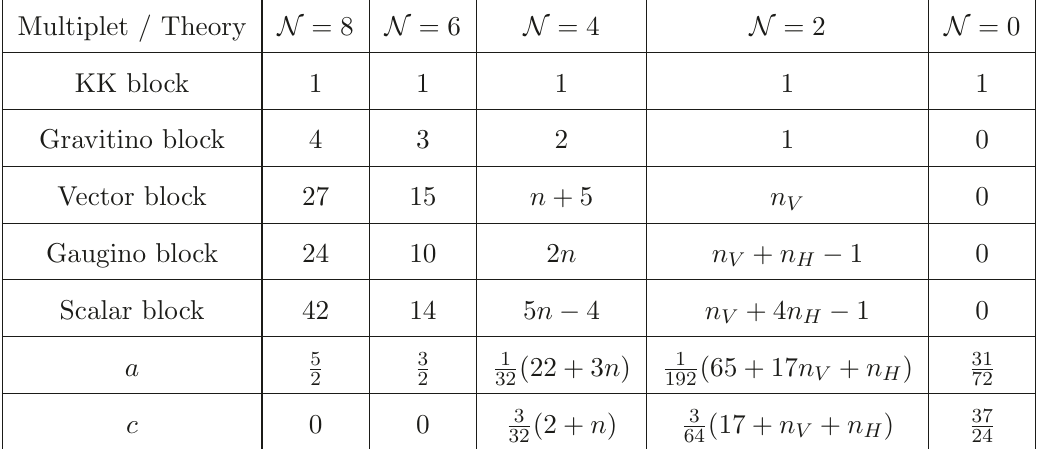
= 4 matter multiplets. For = 2, N N